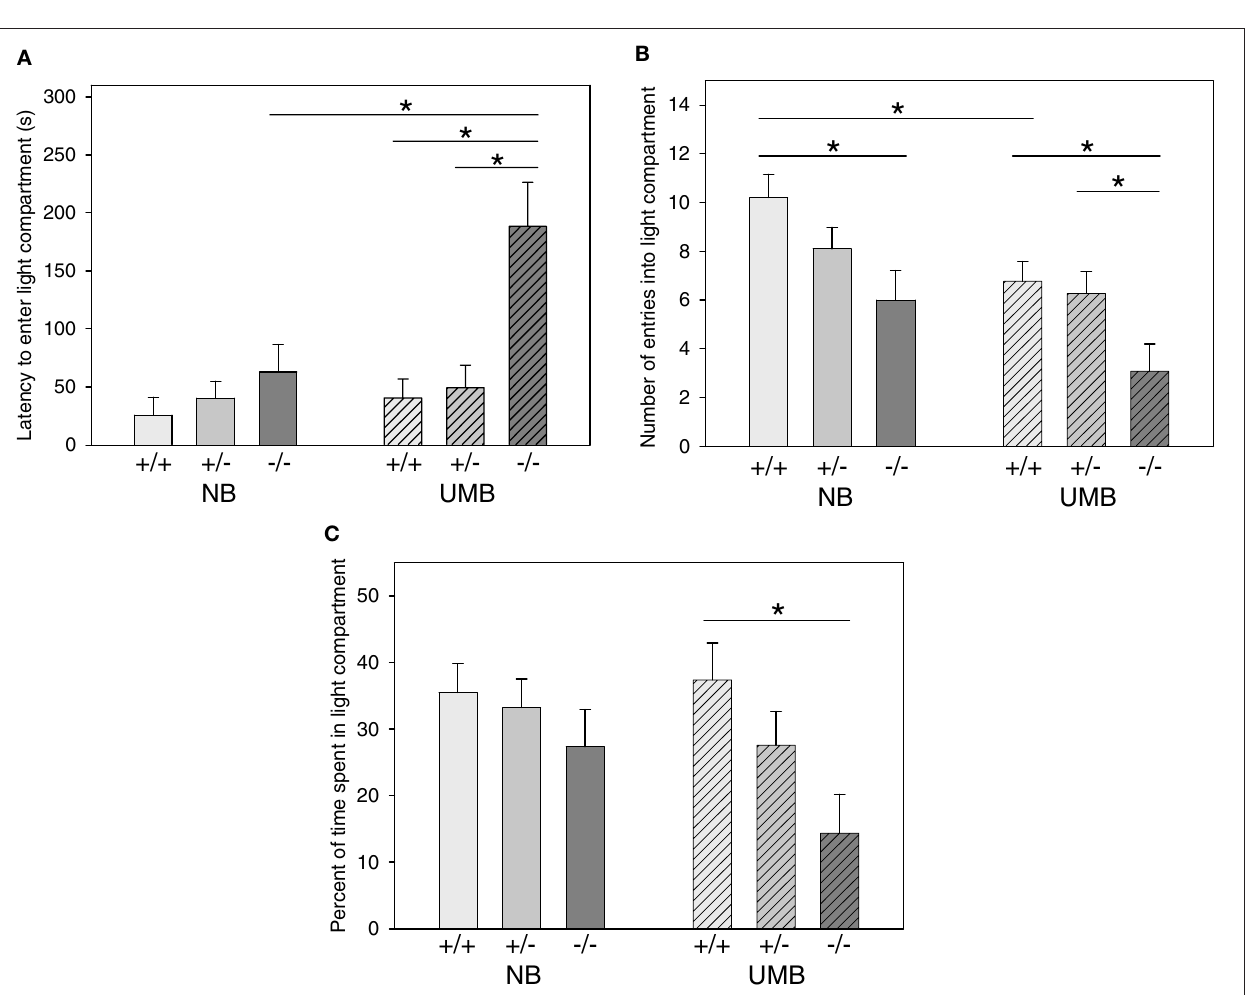
FIGURE 3 | Dark light test. NB, neutral bedding; UMB, unfamiliar male bedding; + / + , + / − , − / − : 5-HTT genotypes. Data are shown as mean + SEM. Statistics: ANOVA, post hoc testing: Bonferroni corrected t -tests: * P < 0.05. Data were obtained from 36 NB males (6 + / + , 19 + / − , 11 − / − mice), 28 NB females (13 + / + , 9 + / − , 6 − / − mice), 34 UMB males (10 + / + , 17 + / − , 7 − / − mice) and 19 UMB females